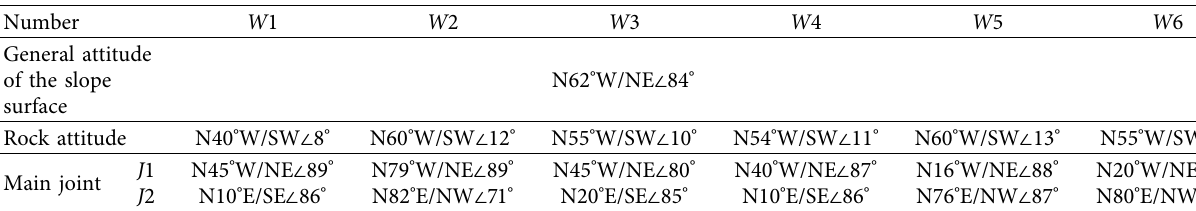
Figure 5: Collapse formation mode (the order of collapse is from (a) to (d)). Table 2: The basic attitude of the dangerous rock mass.